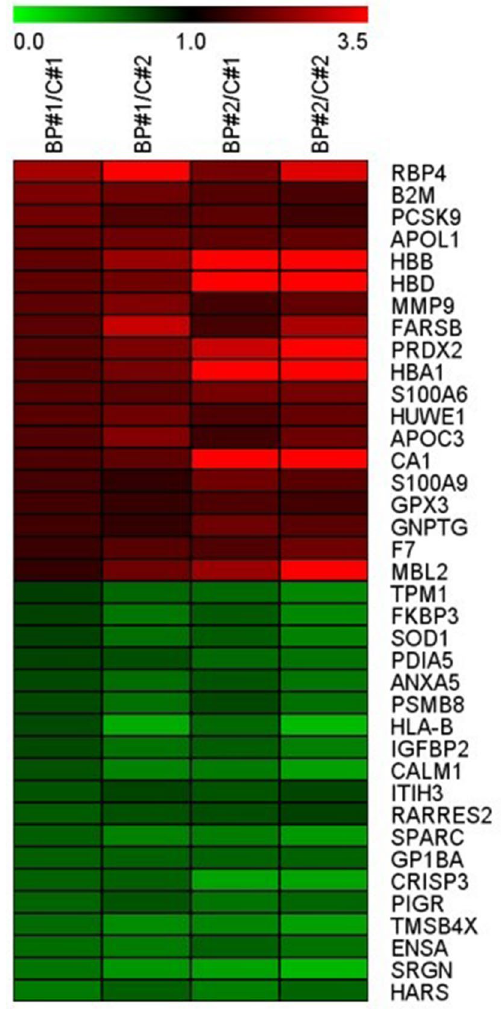
Figure 2. Heatmap of candidate proteins: the top 38 differentially expressed protein candidates (19 with upregulation and 19 with downregulation) presented with